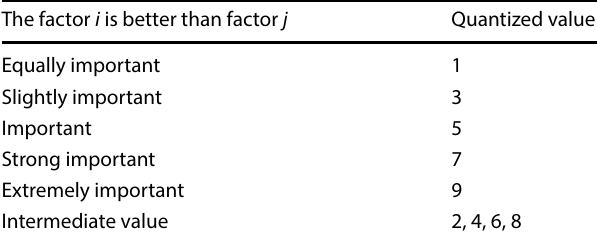
Table 5 Scale table